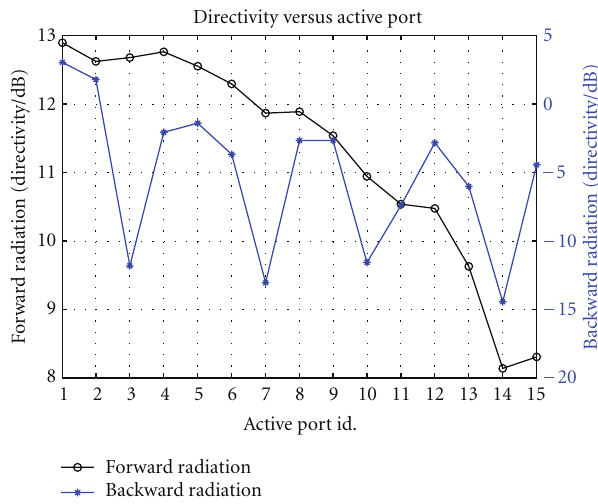
Figure 26: Forward and backward directivity as a function of the fed